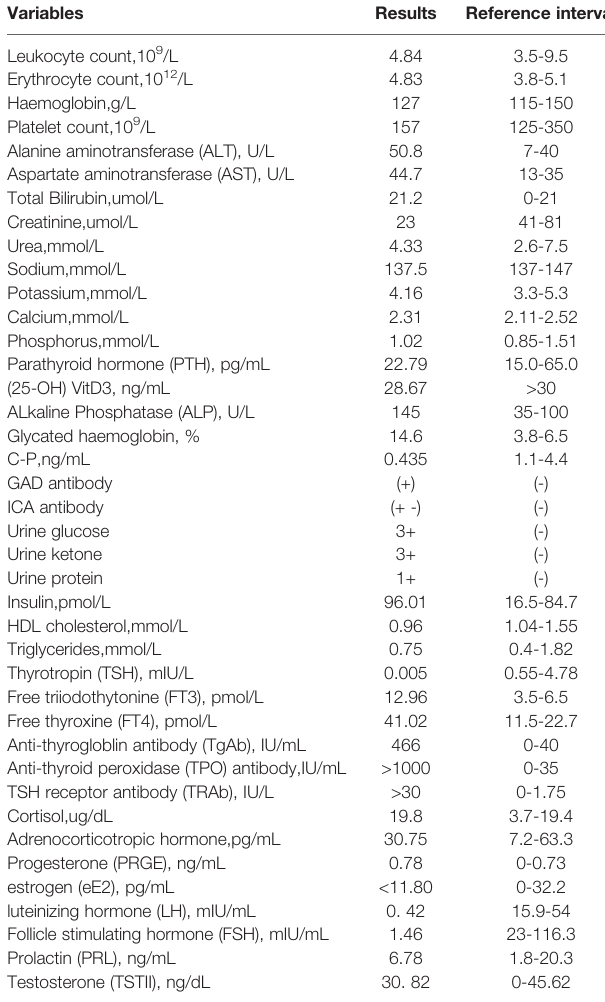
TABLE 1 | Laboratory data on